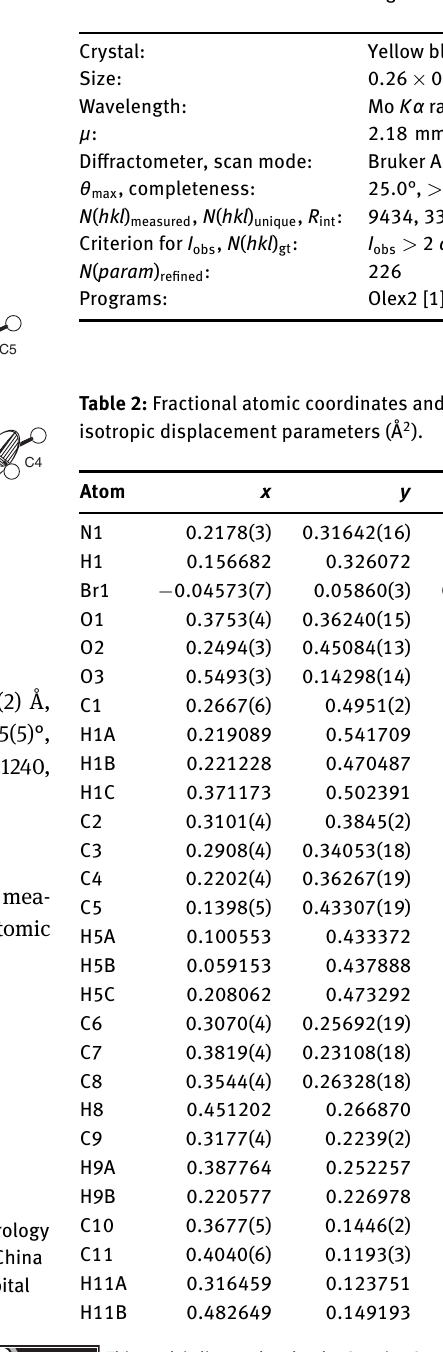
Table 1: Data collection and handling.